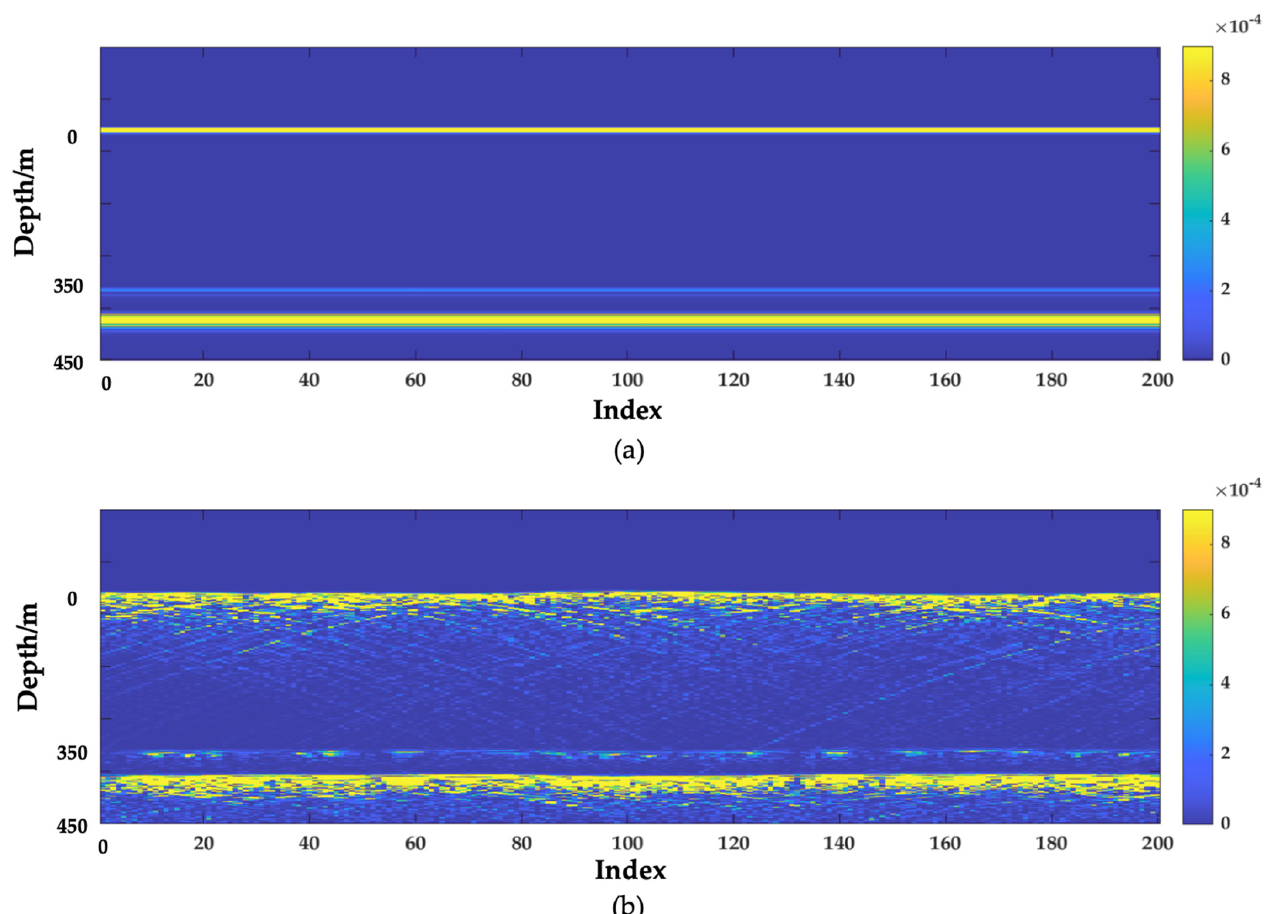
Figure 13. Comparisons of simulated radargram on a smooth ( a ) and a rough ( b ) surface. The horizontal axis represents the points number, and we set the distance between every two points as 10 m. The vertical axis shows the depth in meters.